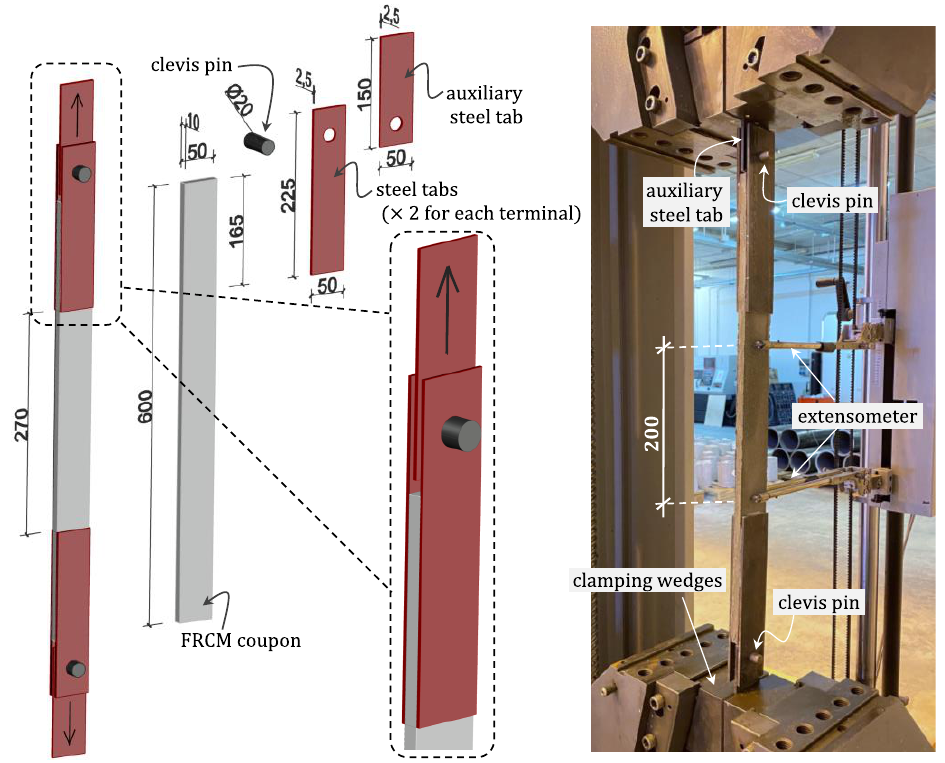
Figure 6. Dimensions (units in [mm]) and photograph of the clevis-grip tensile test configuration. A clevis-grip system constituted by a clevis pin with diameter Ø 20 mm and an aux-